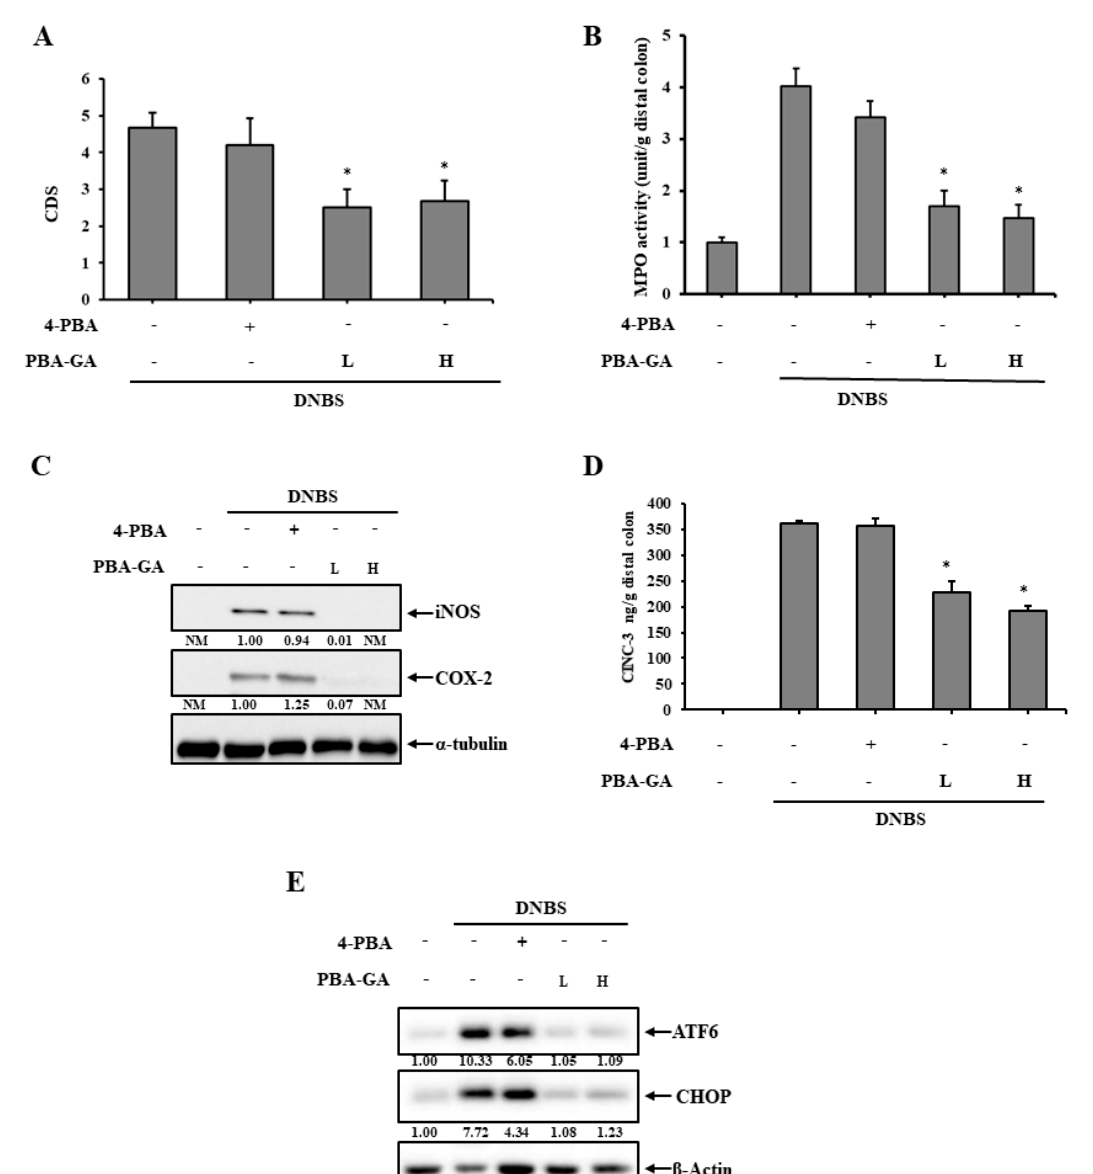
Figure 3. PBA-GA ameliorates 2,4-dinitrobenzenesulfonic acid (DNBS)-induced rat colitis by attenuating endoplasmic reticulum (ER) stress . ( A – E ) Three days after the induction of colitis, PBA-GA (17.9 (L) and 53.6 mg/kg ( H ), equivalent to 10 and 30.0 mg/kg of 4-PBA) dissolved in 1.0 mL of PBS (pH 7.4) was administered orally to rats once daily. The rats were sacrificed after the seventh dose. For comparison, 4-PBA (30.0 mg/kg) was administered in the same manner as PBA-GA. ( A ) The colonic damage score (CDS) was determined for each group, as described in the “Materials and Methods” section. ( B ) Myeloperoxidase (MPO) activity was measured in the inflamed distal colons (4.0 cm). Inflammatory mediators, including ( C ) iNOS, COX-2 and ( D ) CINC-3, were measured in the inflamed colon. α -Tubulin was used as a loading control to normalize the levels of iNOS and COX-2. ( E ) The levels of the ER stress marker proteins, ATF6 and CHOP, were monitored in the inflamed colon. β -Actin was used as a loading control to normalize the levels of ATF6 and CHOP. * p < 0.05 vs. DNBS control, NM: not measurable. The data represent the means ± SD ( n = 5). 3.4. PBA-GA Is as Effective as SSZ in Mitigating DNBS-Induced Rat Colitis SSZ, a colon-targeted prodrug of 5-aminosalicylic acid (5-ASA), is an anti-inflammatory drug used clinically for the treatment of mild to moderate IBD. Thus, the anti-colitic effects of PBA-GA in